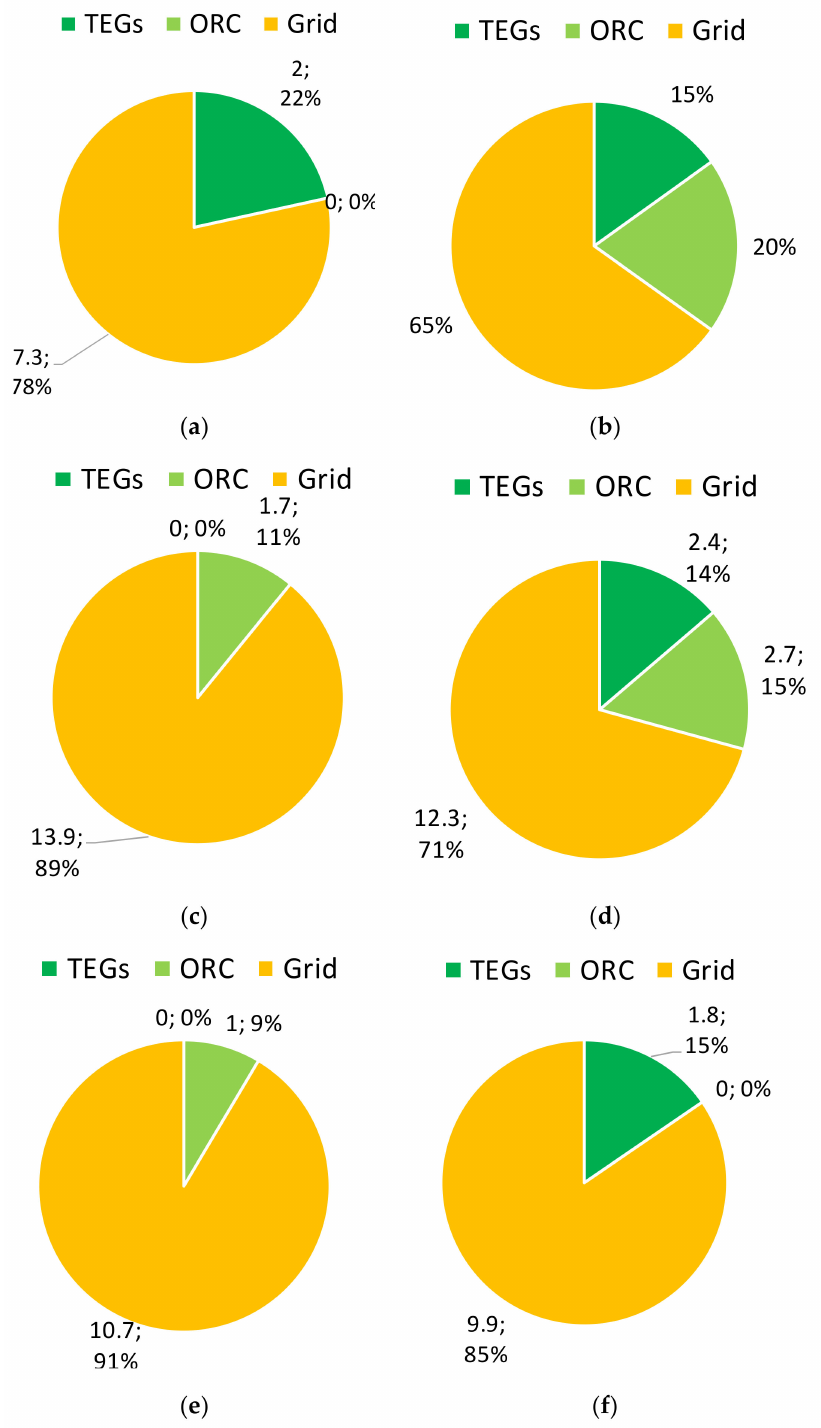
Figure 11. Electricity generation sources in Madrid for 50% rooftop coverage with solar collectors ( a ) and 100% ( b ); in Berlin for 50% rooftop coverage with solar collectors ( c ) and 100% ( d ) and in Helsinki for 50% rooftop coverage with solar collectors ( e ) and 100% ( f ). The numbers in the plots indicate the kWh/(m 2 y) for each contribution and the relative share of the overall electricity consumption for the heat pump and